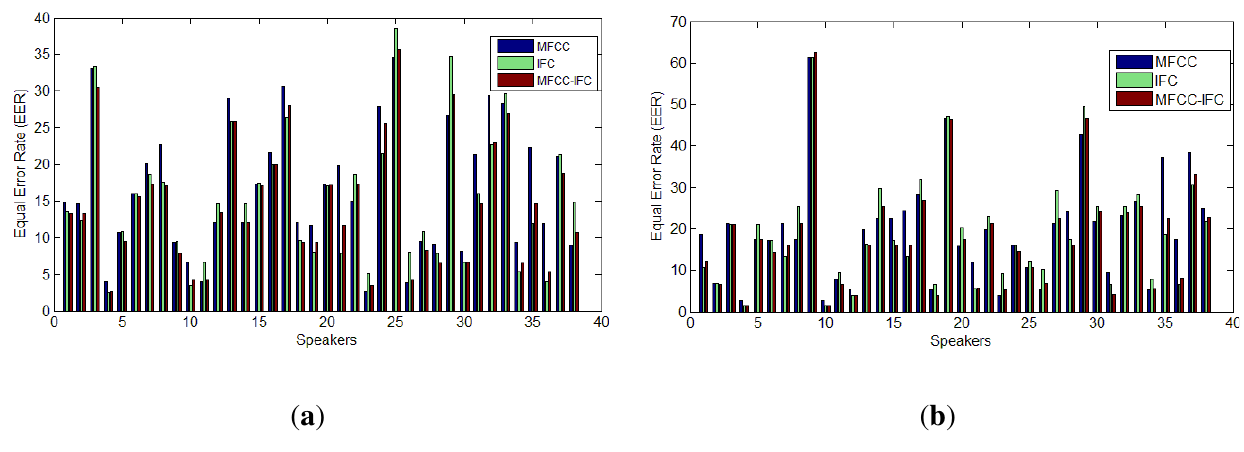
Figure 9. EER for each speaker ( a ) in the match case and ( b ) in the mismatch case.